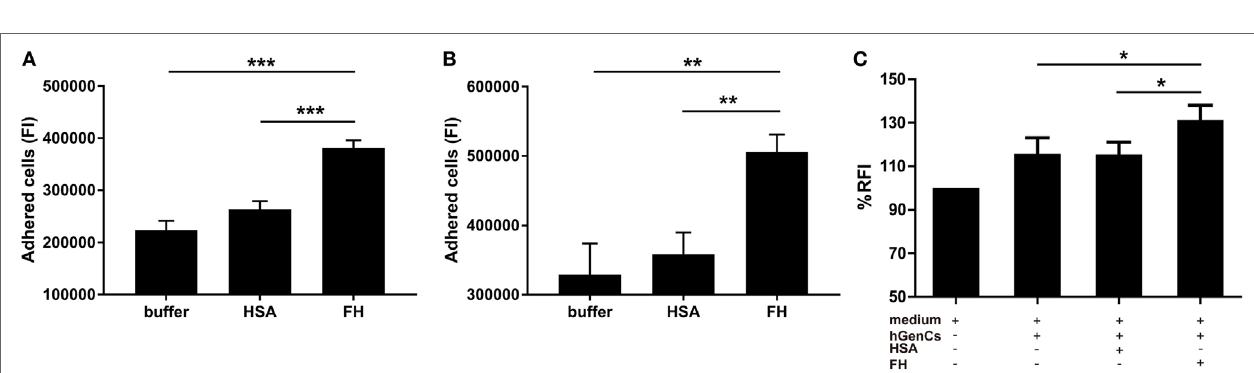
FigUre 4 | Factor H (FH) enhances neutrophil adhesion and migration to hGEnCs. In all assays, neutrophils were stained with Cell tracker green. (a) TNF- α primed neutrophils pre-incubated with FH or controls were added to endothelial monolayers and allowed to adhere. Adherent cells were quantified by plate fluorimeter. (B) hGEnC monolayers were pretreated with FH or controls. TNF- α primed neutrophils were added and allowed to adhere. Adherent cells were quantified. Results are expressed as mean ± SD of fluorescence intensity (FI) values derived from five independent experiments. (c) hGEnC monolayers grown on the lower chamber of transwells were pre-incubated with FH, human serum albumin (HSA), or medium. TNF- α primed neutrophils were added to the upper wells. The migration of neutrophils through a membrane insert was quantified by measuring the fluorescence in the lower chamber. Transwells without cultivated hGEnCs were used as negative controls. The data were normalized after subtraction of negative controls and represent mean percentage values ± SD from five experiments performed with different cell donors (* P < 0.05; ** P < 0.01; *** P <